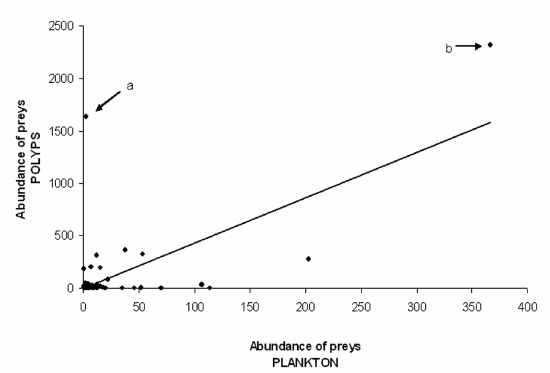
Fig. 6- Spearman correlation coefficient between total abundances of prey items found in gastric cavities of the polyps of Carijoa riisei and in the plankton at Porto de Galinhas beach. Outliers: a, Mastogloia sp; b, Oscillatoria sp